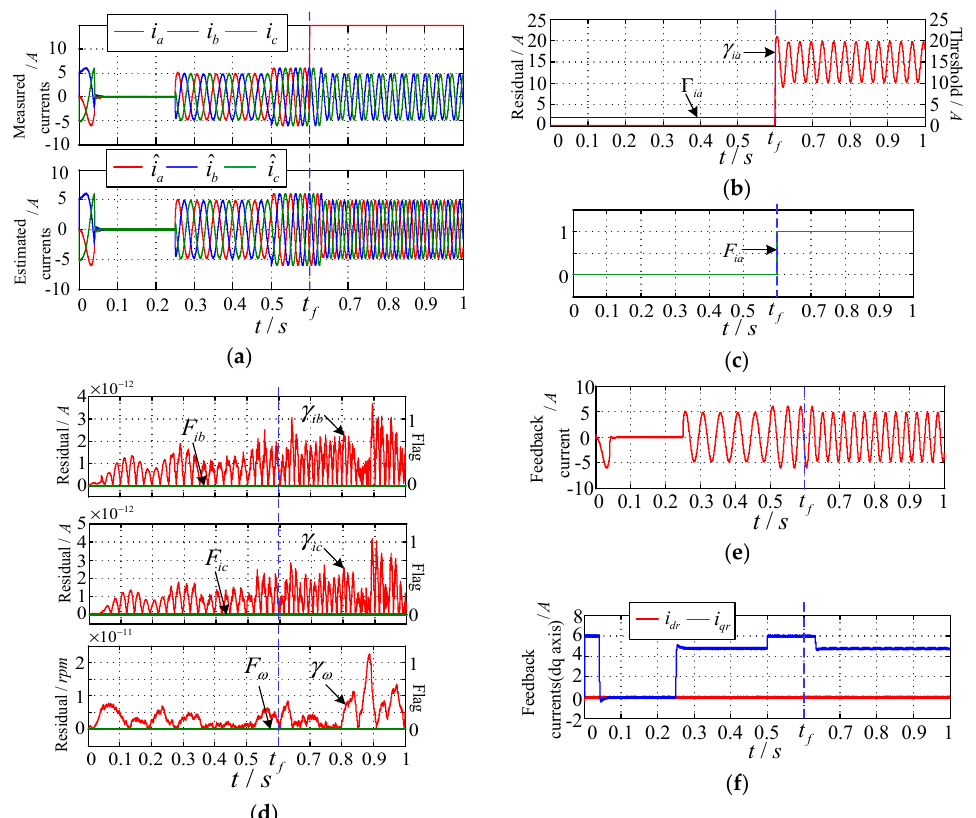
Figure 6. The system simulation waveforms when the a -phase current sensor is stuck. ( a ) The measured signal i abc and estimated signal ˆ i abc of the three-phase stator current; ( b ) a -phase current residual γ ia and threshold Γ ia ; ( c ) The fault flag F ia of a -phase current sensor; ( d ) b -phase and c -phase current and speed residuals and fault flags; ( e ) a -phase closed-loop feedback current i ar ; ( f ) Closed-loop feedback current i dqr in the dq coordinate system.